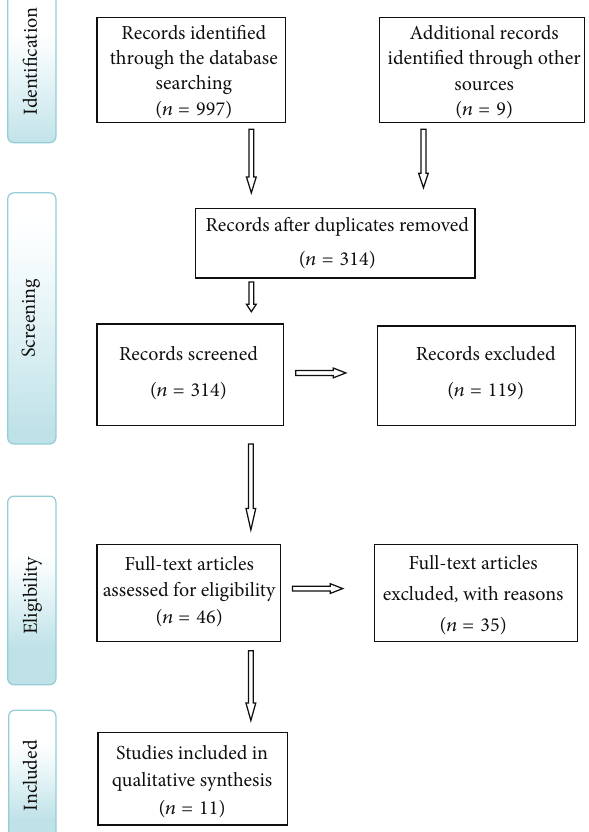
Figure 1: Methodology followed in the article selection process (adapted from Moher et al.